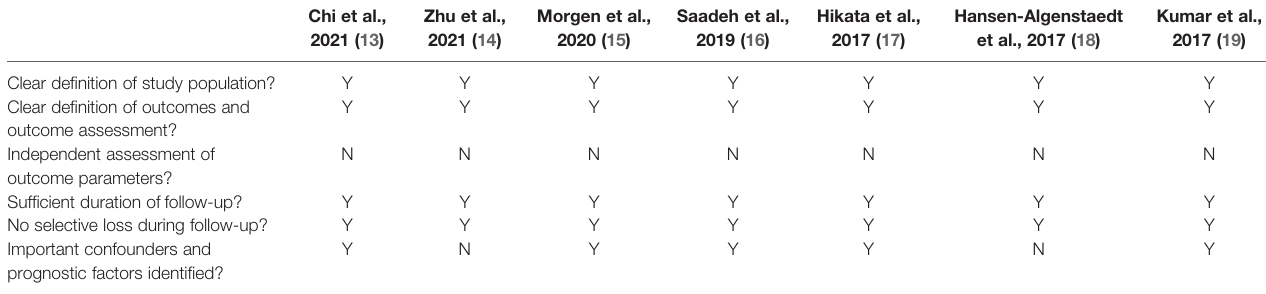
TABLE 2 | Results of MOOSE assessment for quality of evidence and risk of bias assessment for the included studies Y, yes; N, no. Chi et al., 2021 (13)